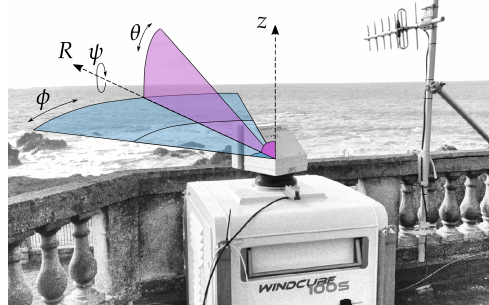
Figure 1. The sLiDAR on the balcony of a seafront villa at Le Croisic, France. Radial Line-Of-Sight ( R , LOS), and vertical ( z ) axis. Roll ( ψ ), pitch (elevation angle θ ), and yaw (azimuth angle φ ) angular